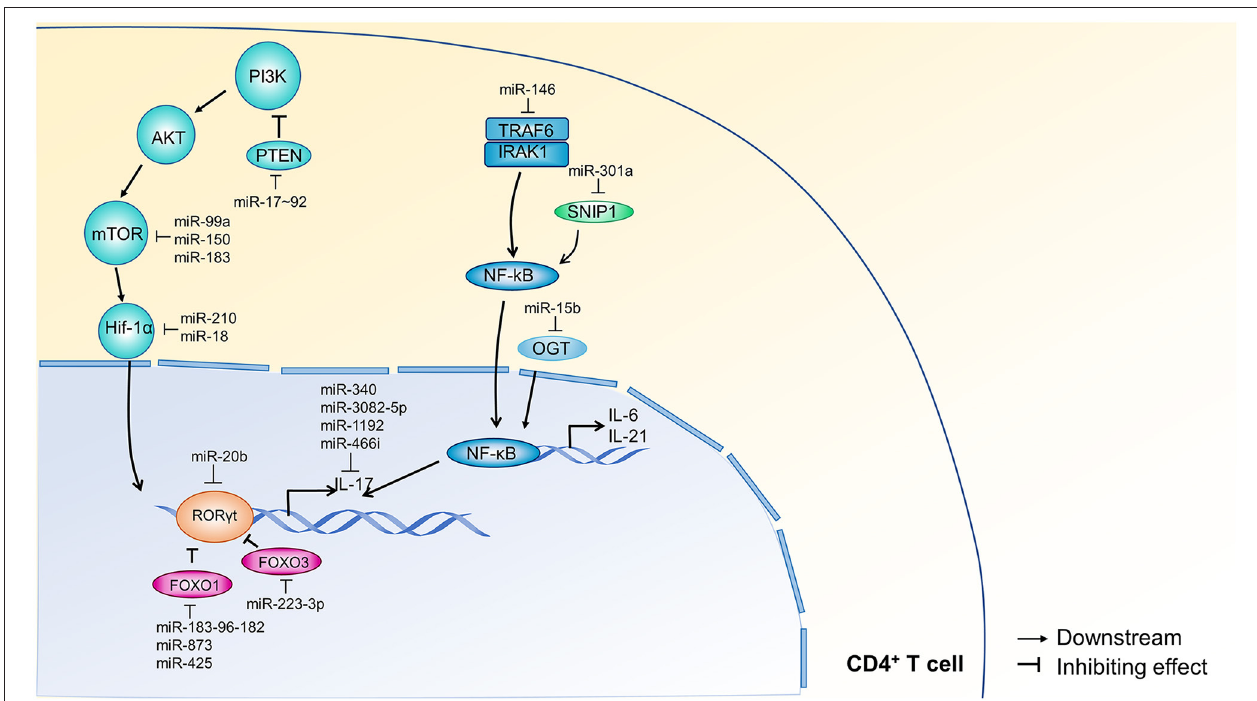
FIGURE 3 | miRNA regulation of NF- κ B and PI3K signal transduction pathways during Th17 cell differentiation. PI3K-AKT-mTOR-Hif-1 α signaling is required for Th17 cell expansion, and NF- κ B signaling contributes to the autocrine production of IL-6 and IL-21 in T cells. PI3K signals through AKT and mTOR to activate Hif-1 α and downstream transcription. PTEN is a negative inhibitor of PI3K and is targeted by miR-17 ∼ 92 ( 55). Additionally, miR-183 (56), miR-99a, and miR-150 (57) inhibit mTOR; miR-210 and miR-18 ( 29, 58) inhibit Hif-1 α . TRAF6/IRAK1 and SNIP1 are upstream regulators of NF- κ B, which contributes to the transcription of IL-6, IL-21, and IL-17. TRAF6 and IRAK1 are inhibited by miR-146 (53), and SNIP1 is inhibited by miR-301a (30). OGT also contributes to NF- κ B-mediated transcription and is targeted by miR-15b ( 54). Within the nucleus, miR-20b (47) targets ROR, which is also inhibited by FOXO1 and FOXO3. FOXO1 is targeted by miR-183-96-182 (15), miR-873 (59), and miR-425 (60), and FOXO3 is targeted by miR-223-3p (61). IL-17 itself is inhibited by miR-340, miR-3082-5p, miR-1192, and miR466i. Arrow heads indicate a downstream response, and blunt lines indicate inhibition. PI3K, phosphoinositide 3-kinase; PTEN, phosphatase and tensin homolog deleted on chromosome ten; AKT, Ser/Thr kinase; mTOR, mammalian target of rapamycin; Hif-1 α , hypoxia inducible factor 1 α ; ROR, retinoic acid-related orphan receptor; FOXO1, factor forkhead box protein O1; FOXO3, factor forkhead box protein O3; TRAF6, tumor necrosis factor receptor-associated factor 6; IRAK1, interleukin-1 receptor-associated kinase; SNIP1, SMAD nuclear interacting protein 1; NF- κ B, nuclear factor κ B; OGT, O-linked N-acetylglucosamine transferase; PCR2, polycomb repressive complex 2; JARID2, Jumonji and AT-rich interaction domain-containing